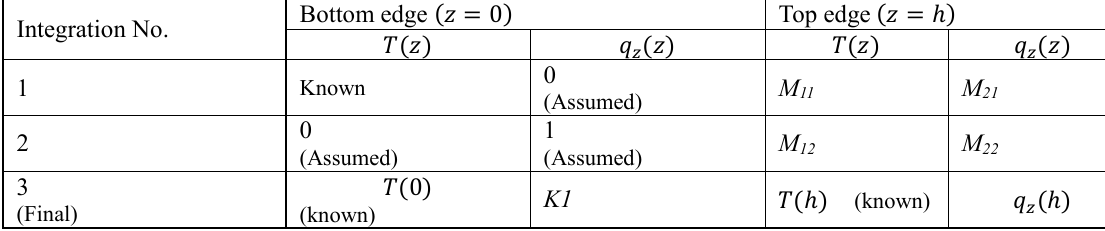
Transformation of BVP into IVP's for thermal analysis Integration No.